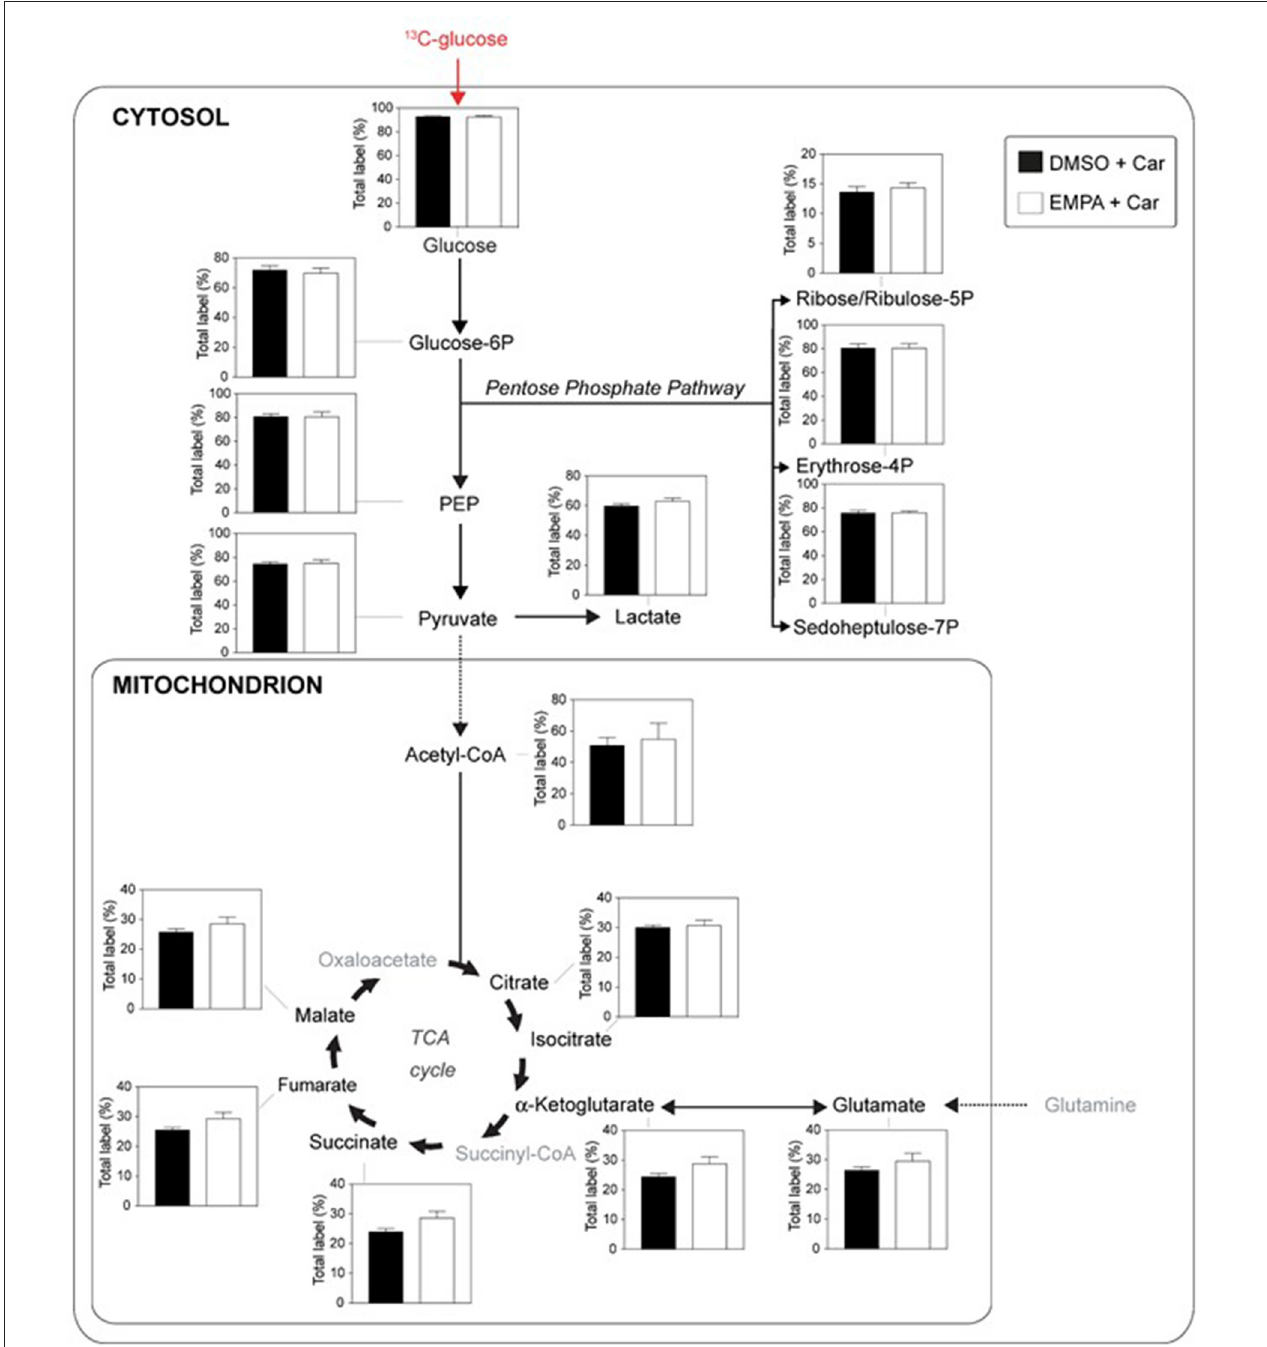
FIGURE 4 | NHE-1 inhibition (cariporide) prevents EMPA’s effects on glucose 13 C labeling of lactate in db/db hearts. EMPA’s effects on 13 C-labeling in metabolites of glycolysis, pentose phosphate pathway and TCA cycle when hearts were perfused with 5.5. mM 13 C glucose and 10 µ M cariporide; DMSO ( n = 9), EMPA ( n = 8), % = % metabolite labeled with 13 C; ppp = pentose phosphate